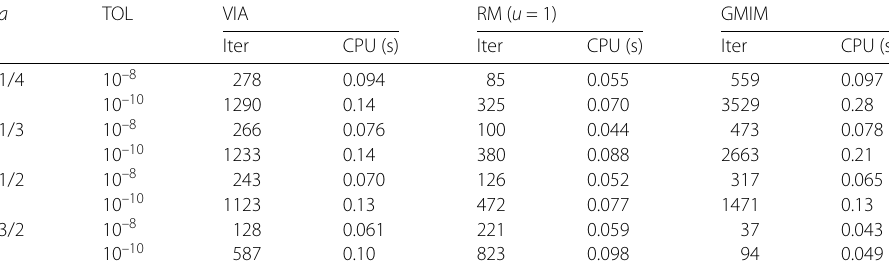
Table 2 Comparison between VIA and other algorithms with x 0 =